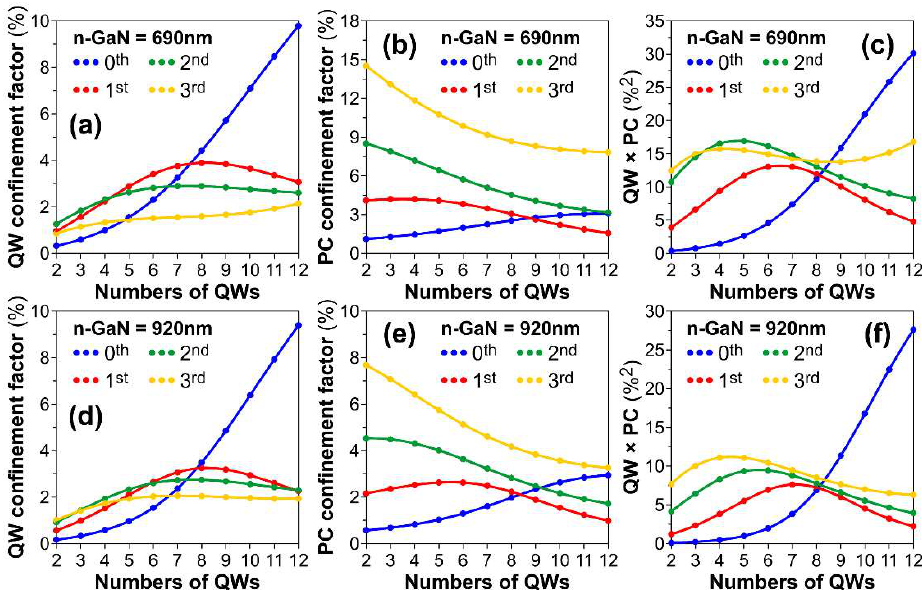
Figure 2. ( a , b ) Calculated QW and PC confinement factors of the µ-PCLED with n-GaN = 690 nm for different numbers of QWs. ( c ) Product of QW and PC confinement factors with n-GaN = 690 nm. ( d,e ) Calculated QW and PC confinement factors of the µ-PCLED with n-GaN = 690 nm for different numbers of QWs. ( f ) Products of QW and PC confinement factors with n-GaN = 920 nm. The PC period and filling factor for the above calculations were set to 232 nm and 0.3.